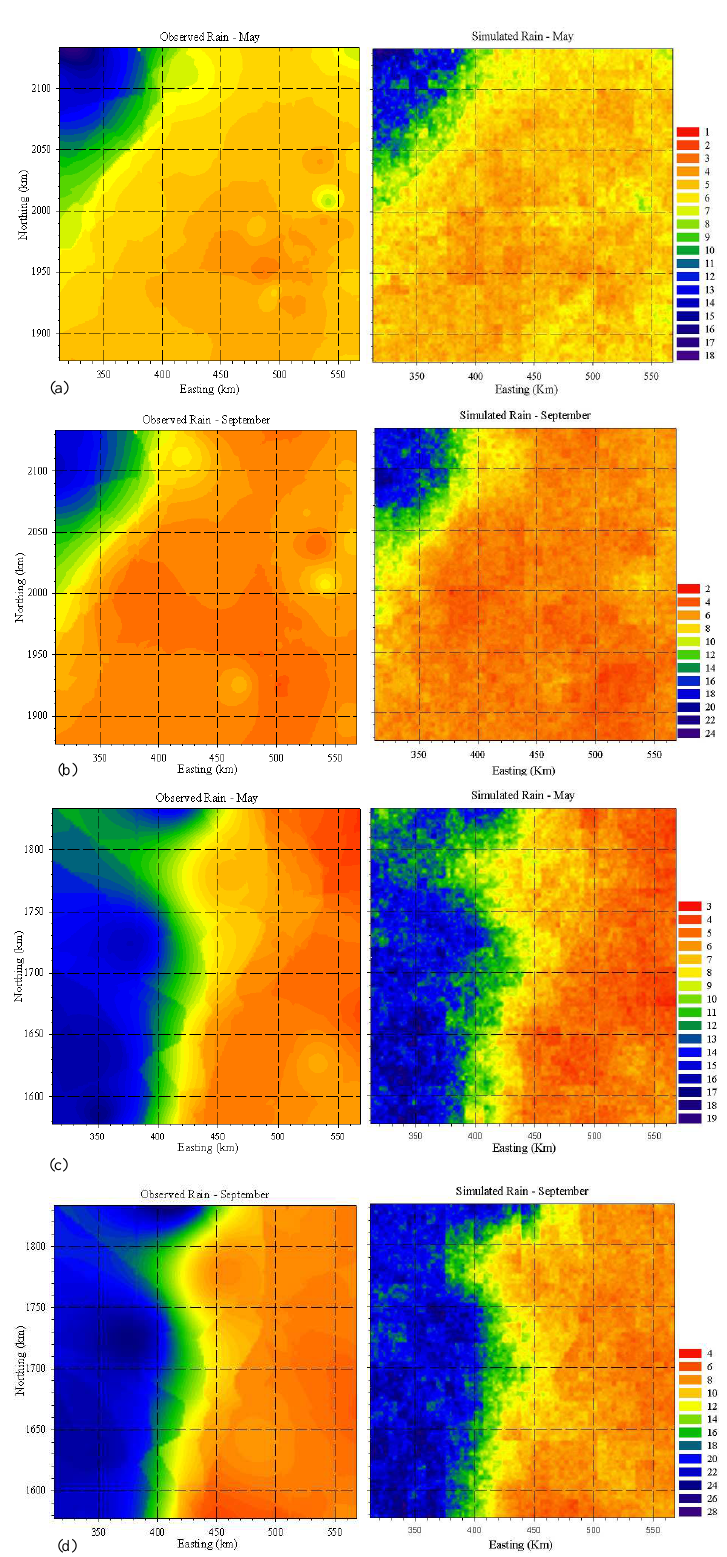
Fig. 12. Spatial heterogeneity between observed and simulated rain field (a) grid 1-May month, (b) grid 1-September month, (c) grid 2-May month, (d) grid 2-September